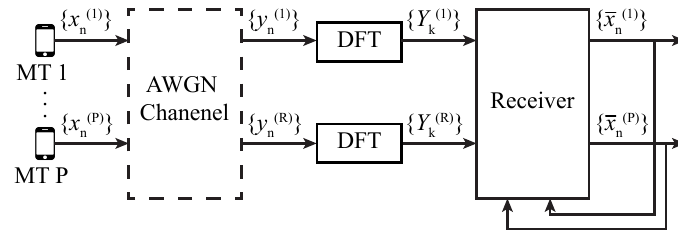
Figure 1. System